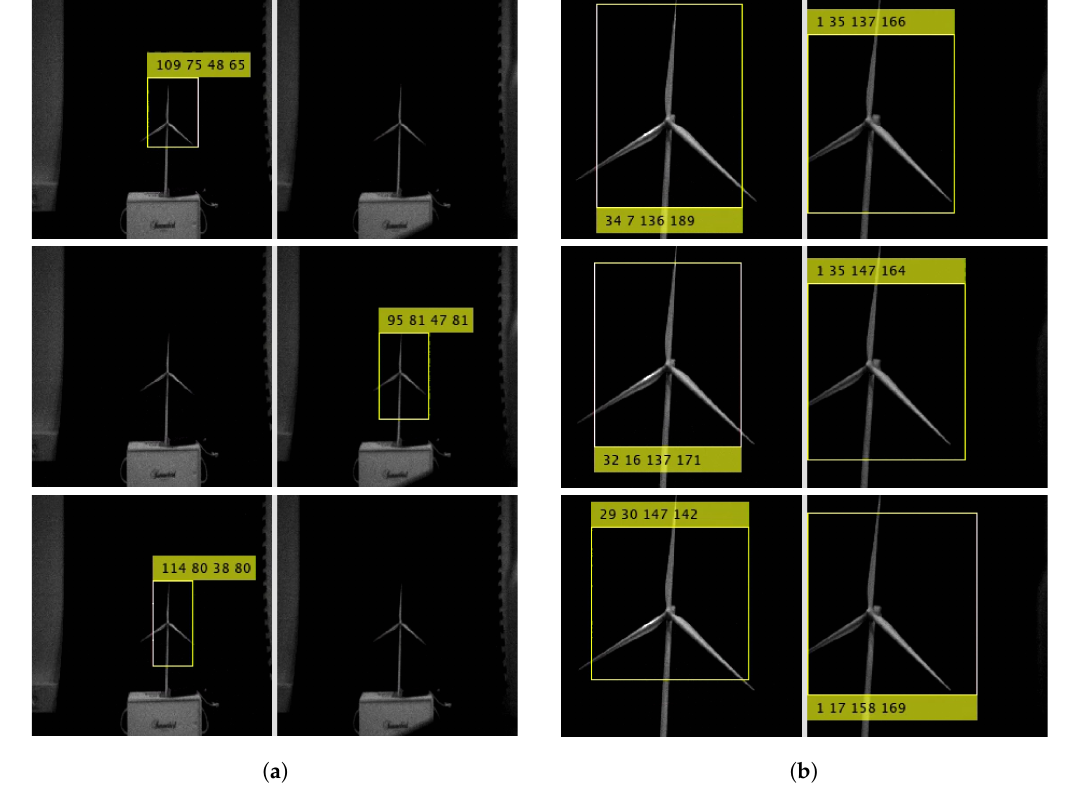
Figure 11. Images captured by the drone’s stereo IR camera. ( a ) Three frames from left and right camera, when the drone is furthest away form the wind turbine, equivalent to 150 s in Figure 10b; ( b ) Three frames from left and right camera, when the drone is nearest to the wind turbine, equivalent to 210 s in Figure